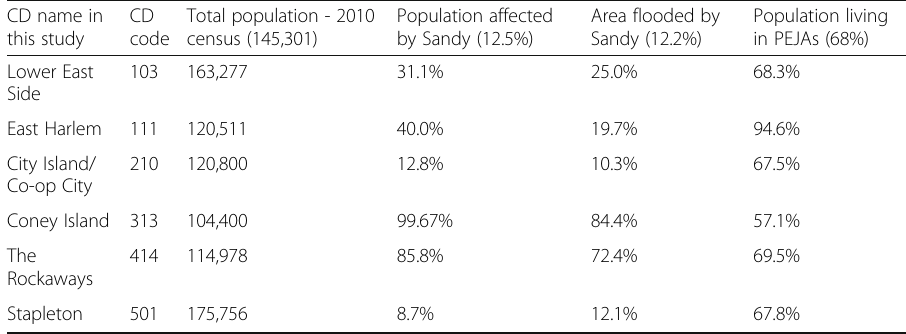
Table 2 Indicators used to select the studied CDs. In the titles row, brackets mean average values for all the CDs that flooded during Superstorm Sandy